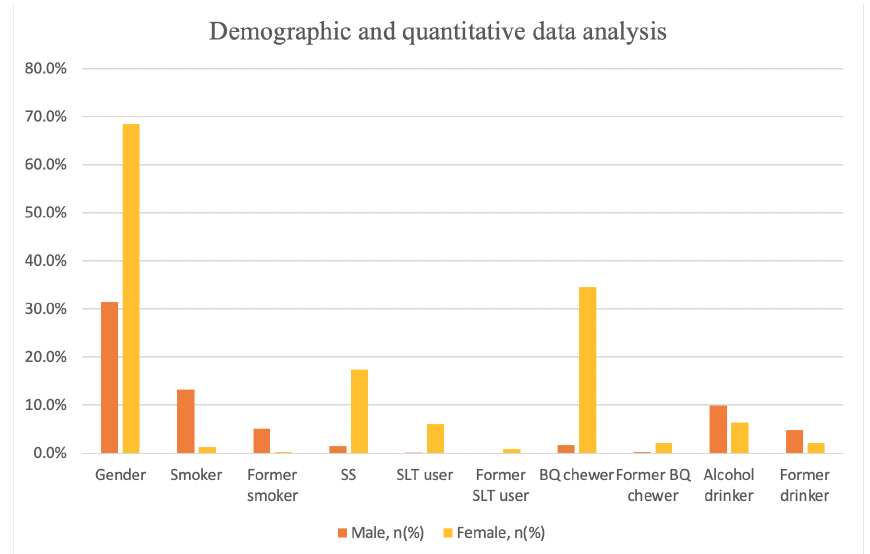
Figure 2. Demographic and quantitative data